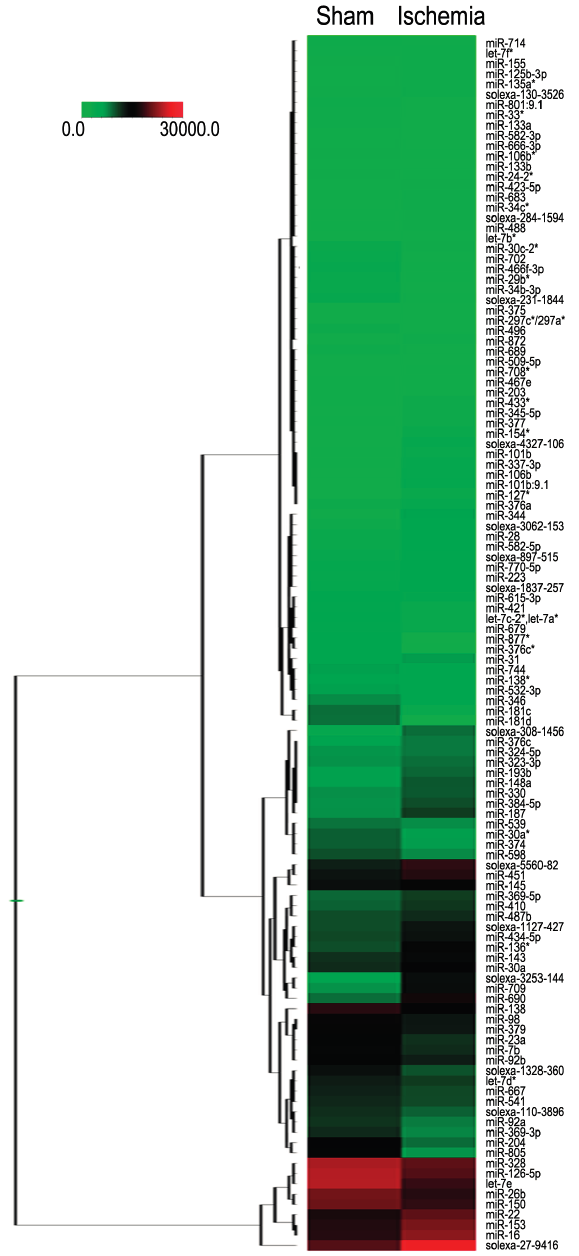
Figure 2. Hierarchical cluster analysis of the altered miRNAs in the infarct region of the MCAO mice. An asterisk following the name indicates a miRNA expressed at low levels relative to the miRNA in the opposite arm of the precursor. The color code in each heat map is linear, with green as the lowest, and red as the highest. The average signals of the changed miRNAs in each of the two groups were clustered using a Euclidean distance function. The miRNAs with the most similar expression patterns were placed next to each other ( n = 12 per